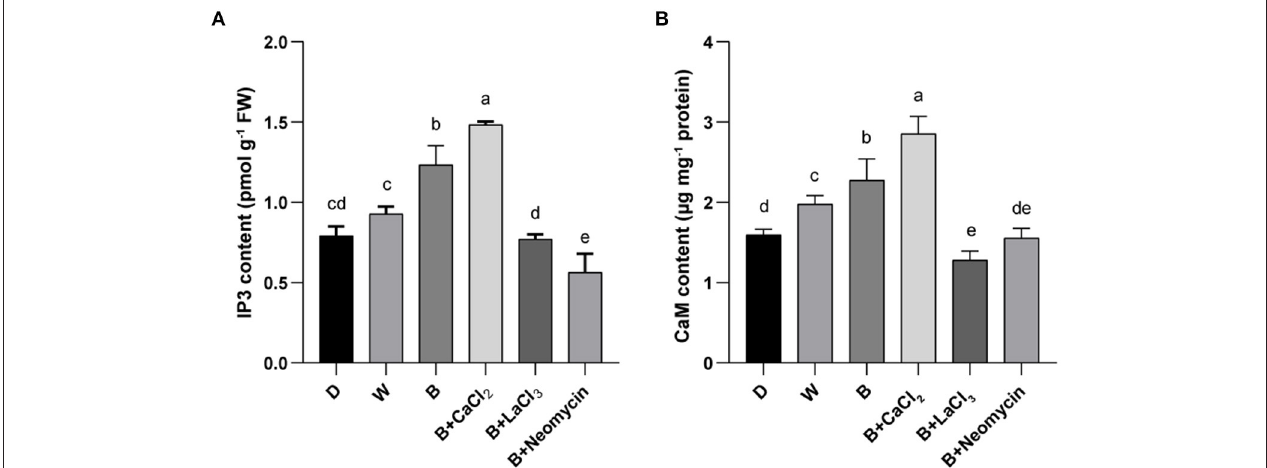
FIGURE 4 | IP3 content (A) and CaM content (B) in “Dongnong 690” hypocotyls at 24h under different conditions. Values are the mean ± SE of triplicate ( n = 3). The different letters represent significant differences among various treatments ( p < 0.05). The different treatments were as follows: (1) D: cultivated with purified water without light; (2) W: cultivated with purified water under white light radiation; (3) B: cultivated with purified water under blue light radiation; (4) B + CaCl 2 : cultivated with 3mM CaCl